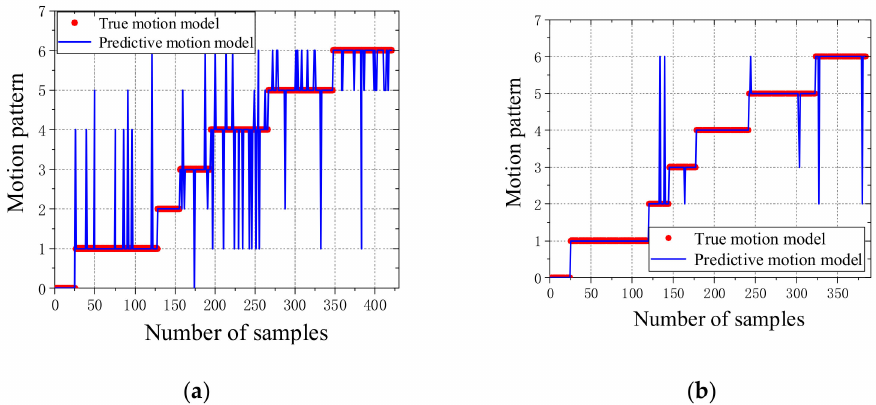
Figure 12. Recognition results of the LSTM model in smaller window lengths. ( a ) Sliding window length of 256 ms. ( b ) Sliding window length of 512